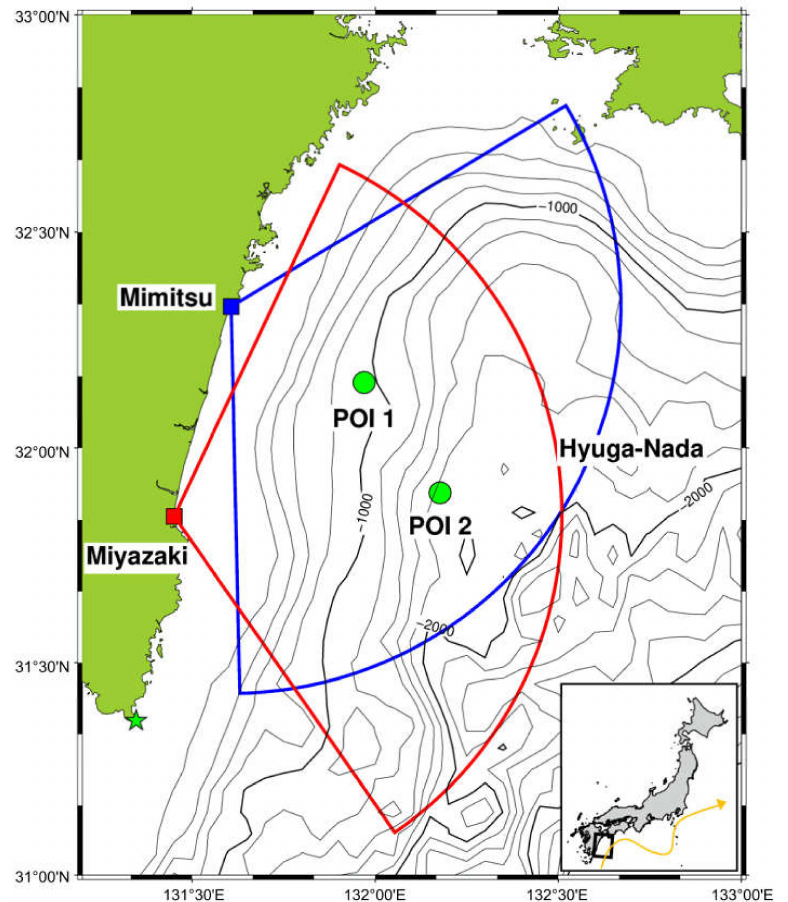
Figure 2. HF radar location and observation area. The red square is the location of Miyazaki Station, and the blue square is the location of Mimitsu Station. The fan shape indicates the observation area of each radar. The green star is the location of Cape Toi where the Japan Coast Guard measures the distance to the Kuroshio Current axis. The green circle is the point of interest used for comparison with the vorticity. The yellow arrow in the lower right shows an example of the flow path of the Kuroshio